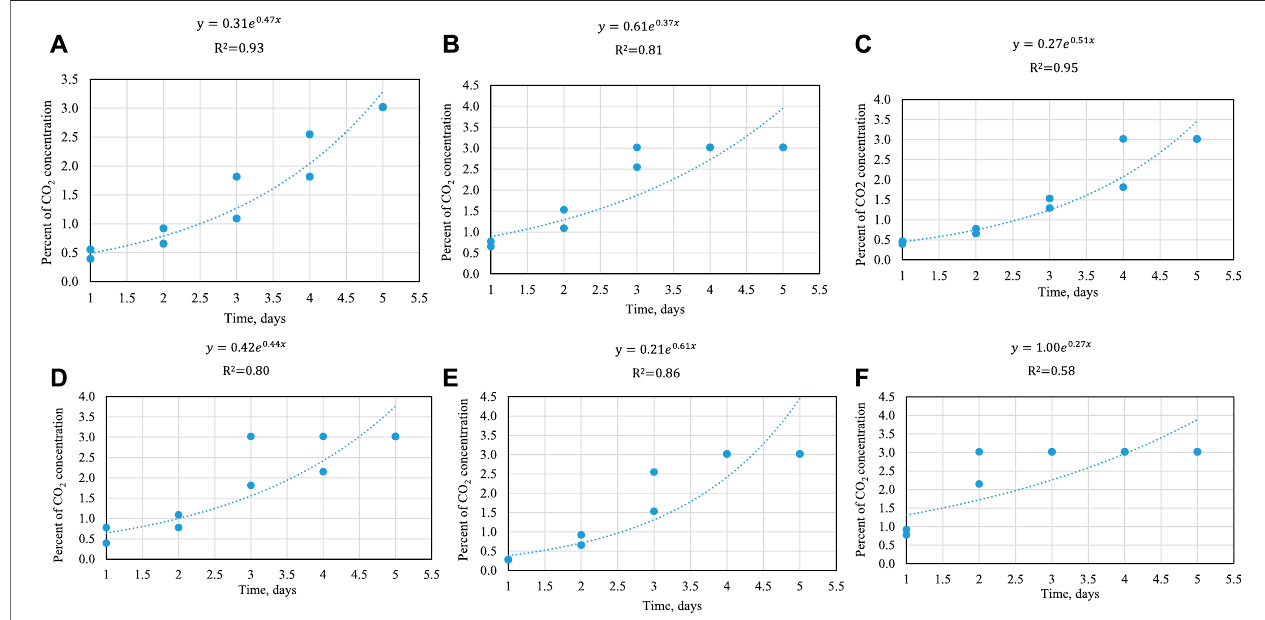
FIGURE 10 | (A) % CO 2 evolution over time in whole stillage at 25 ° C. Each point represents one reading. (B) % CO 2 evolution over time in whole stillage at 35 ° C. Eachpointrepresentsonereading. (C) %CO 2 evolutionovertimeinthinstillageat25 ° C.Eachpointrepresentsonereading. (D) %CO 2 evolutionovertimeinthinstillage at35 ° C.Eachpointrepresentsonereading. (E) %CO 2 evolutionovertimeinsyrupat25 ° C.Eachpointrepresentsonereading. (F) %CO 2 evolutionovertimeinsyrupat 35 ° C. Each point represents one